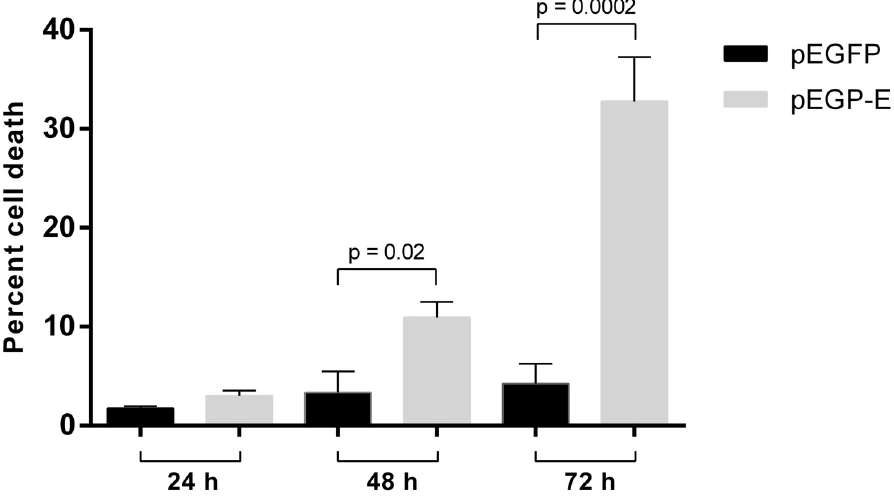
Fig 6. HPV16 E1 induces cell death. HEK 293 T cells were transfected with either pEGFP (black bar) or pEGFP-E1 (gray bar). Cells were stained with Zombie Yellow and percent cell death was analyzed by flow cytometry at 24-, 48-, and 72-hours